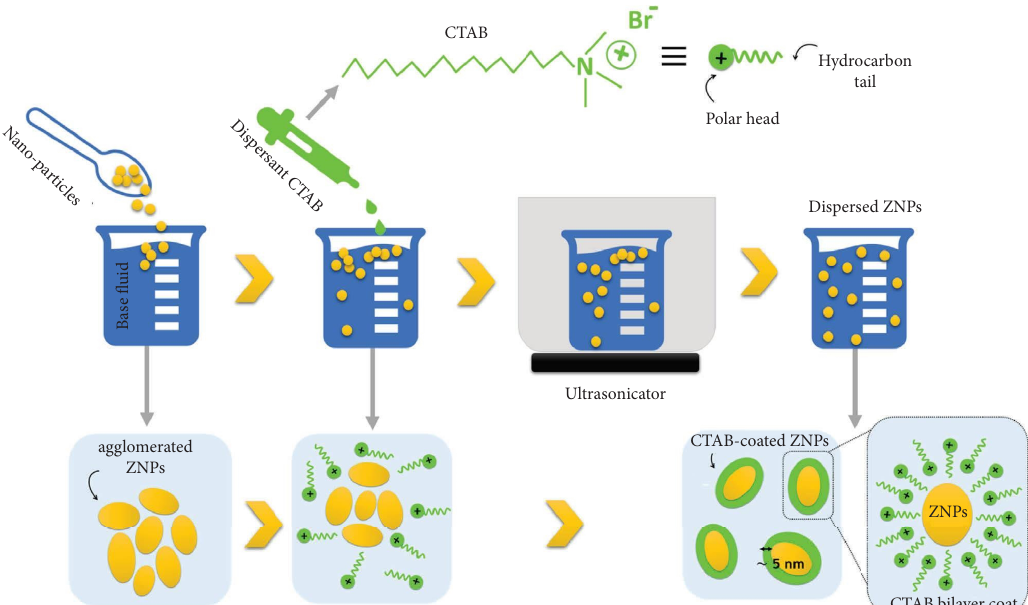
Figure 1: Te conventional method for preparing ZNPs using CTAB